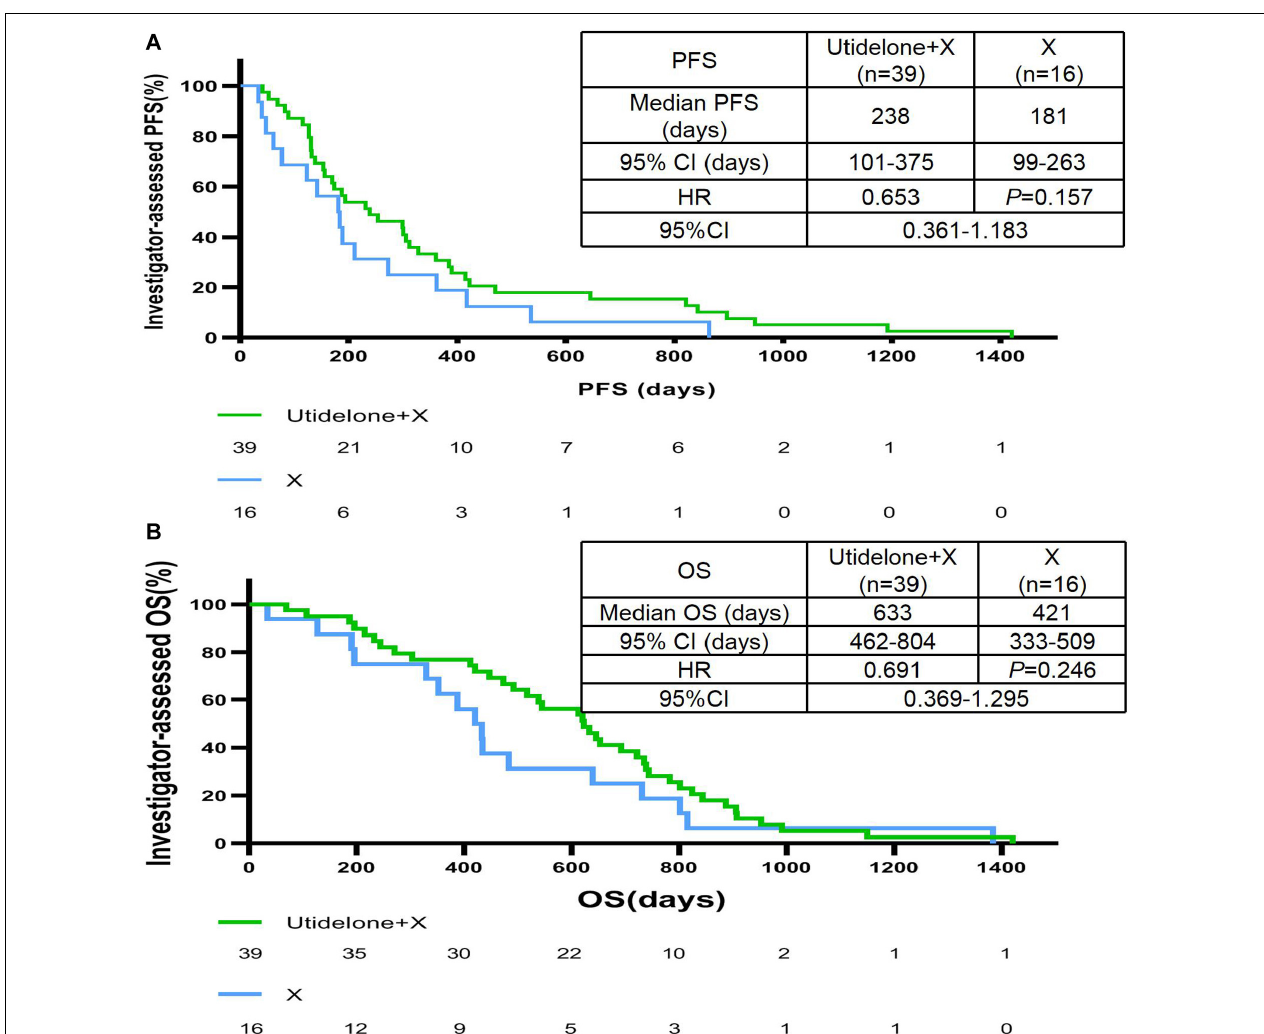
FIGURE 2 | IRC-assessed PFS (A) and OS (B) in our center population. CI, confidence interval; X capecitabine, ECOG PS, Eastern Cooperative Oncology Group performance status; ER, estrogen receptor; HER2, human epidermal growth factor receptor 2; HR, hazard ratio; mo, months; U, utidelone; PFS, progression-free survival; PgR, progesterone receptor; IRC, independent radiology review committee; and OS, overall survival.